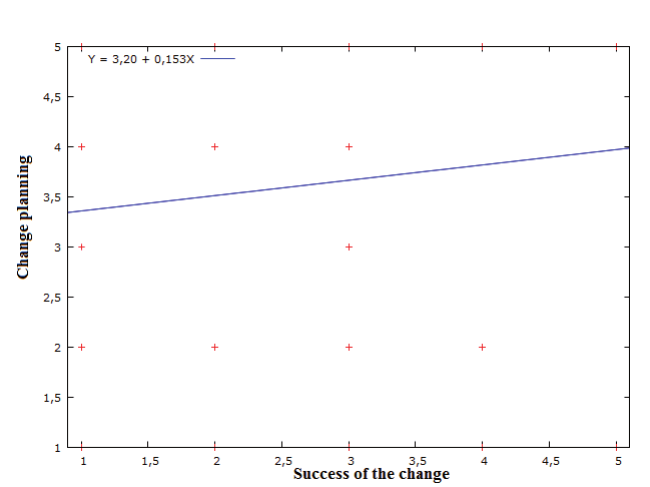
Fig. 2 - X – Y chart: Testing results of the first hypothesis. Source: own processing using